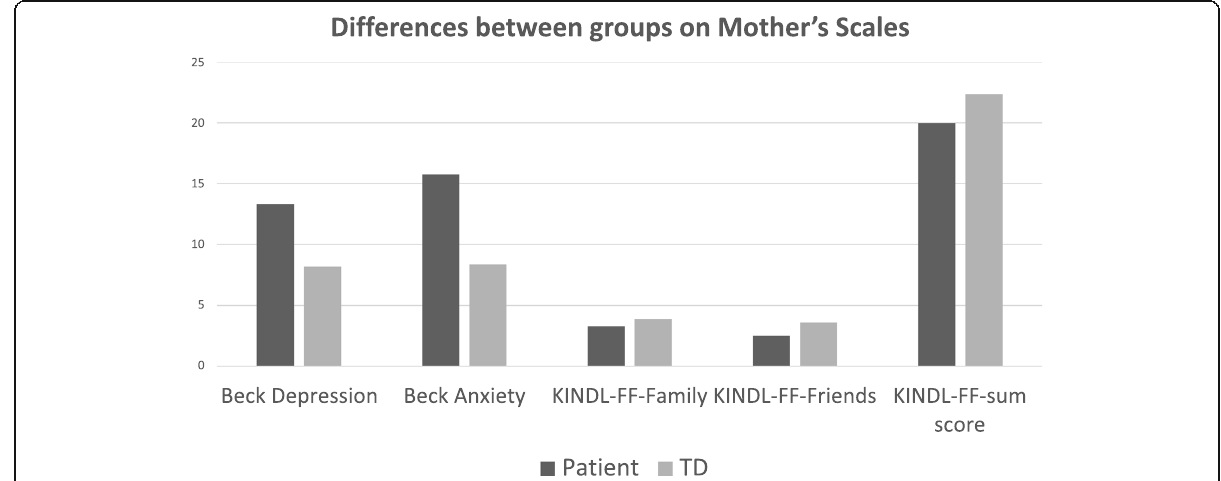
Table 4 Correlation of the outcomes of scales of children and adolescents with outcomes of mothers Beck Anxiety Scores Beck Depression Scores KINDL-FF